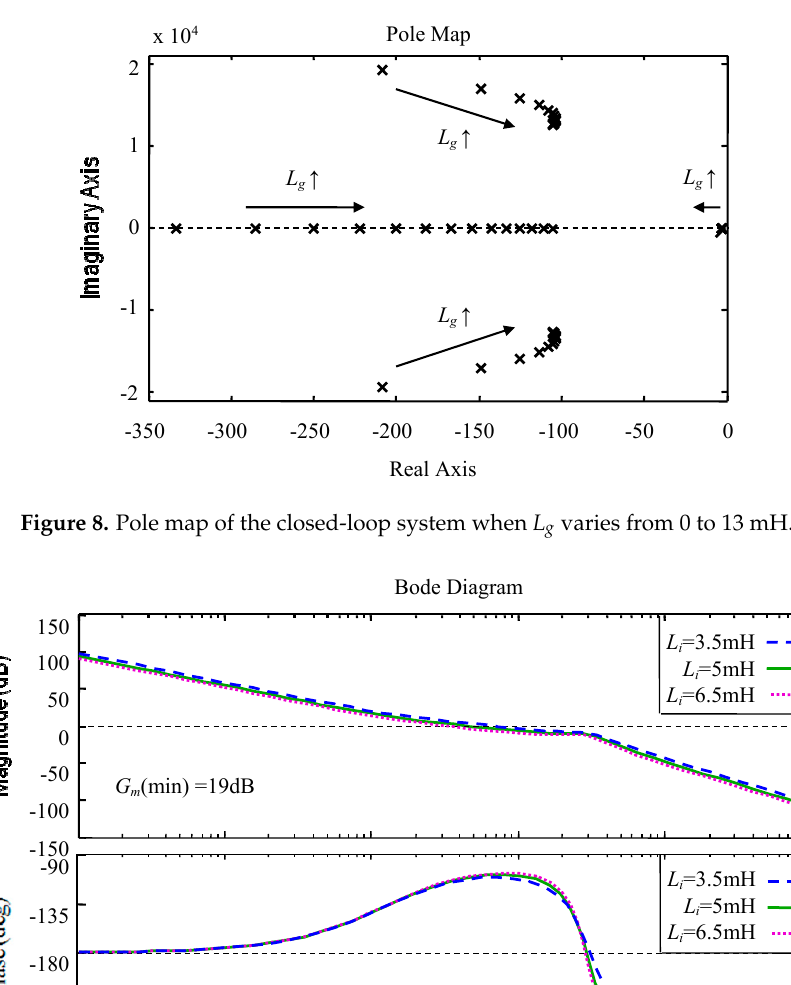
Figure 9. Bode diagram of the open loop system when L i varies from 3.5 mH to 6.5 mH (5 mH ±